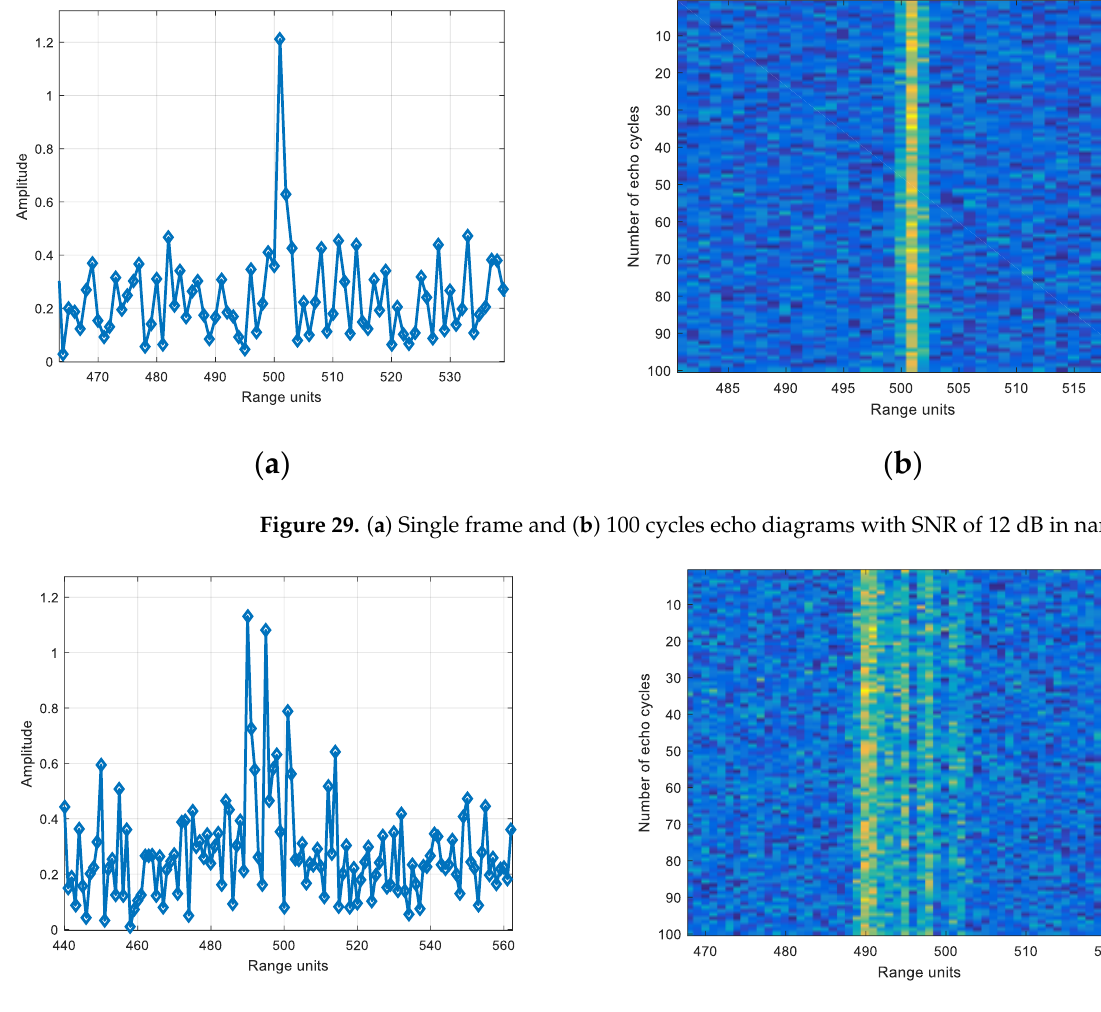
Figure 30. ( a ) Single frame and ( b ) 100 cycles echo diagrams with SNR of 12 dB in wideband.